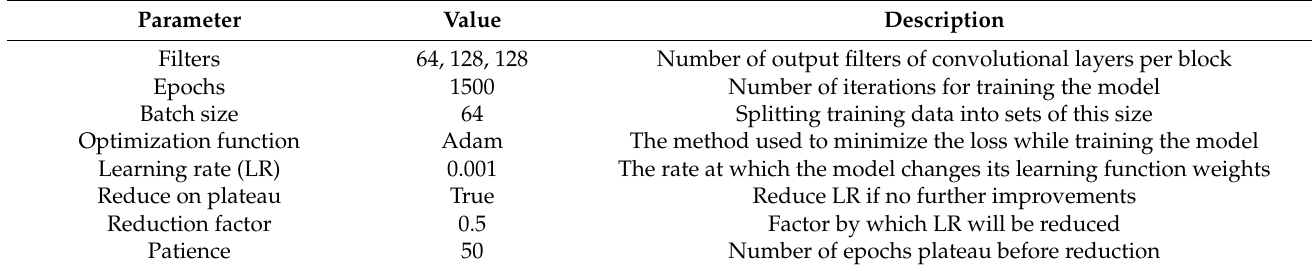
Table 1. ResNet model parameters.